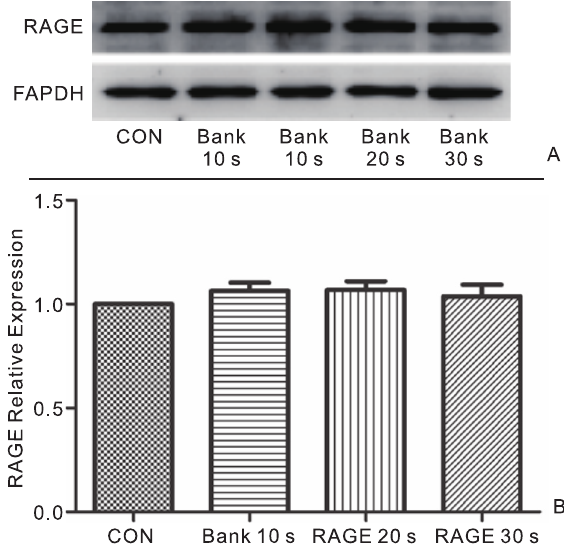
Figure 1 Western-blot analysis showed expression of RAGE in adherent cell group. (A) Expression change of RAGE at various times; (B) Inductions of RAGE relative expression at various times were potted by column graph. The error bars represented the standard deviation ( n =3). There were no statistically significant differences between groups. Con (HCAEC only), Blank (HCAEC+SonoVue microbubble) and RAGE (HCAEC+SonoVue microbubble+RAGE plasmid), Con and Blank served as the internal